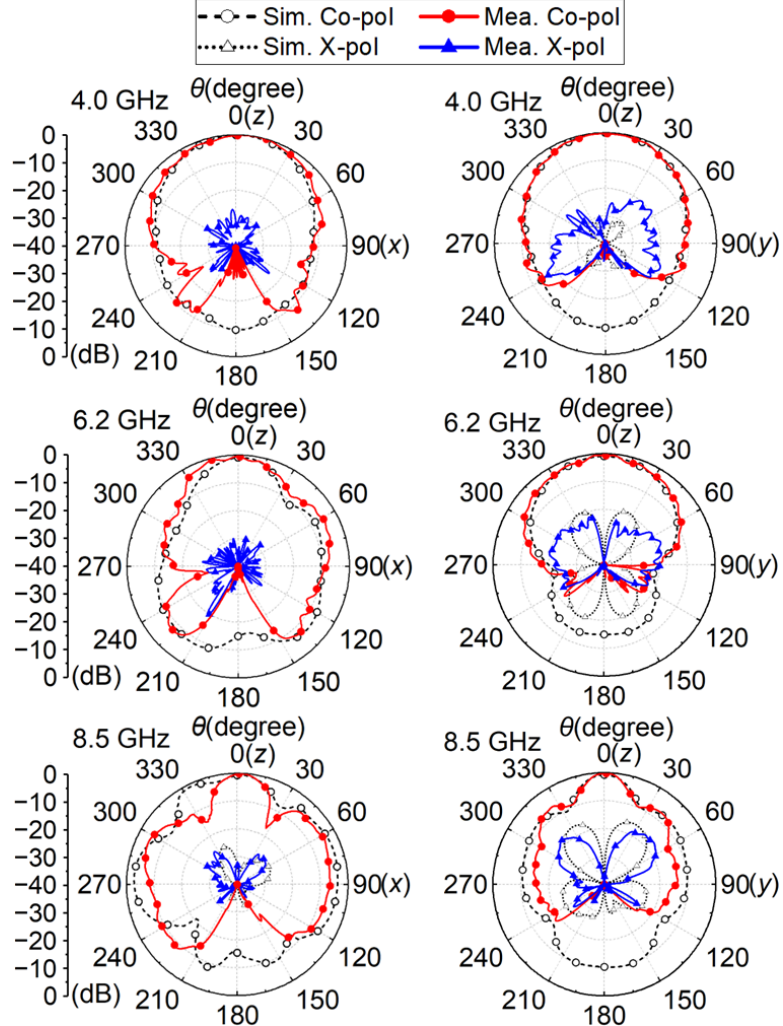
Figure 14. Simulated and measured E-/H- plane (xoz/yoz -plane) cross- and co-polarization radiation patterns of the proposed antenna. Table 1. Comparison of merits with some previously reported metasurface